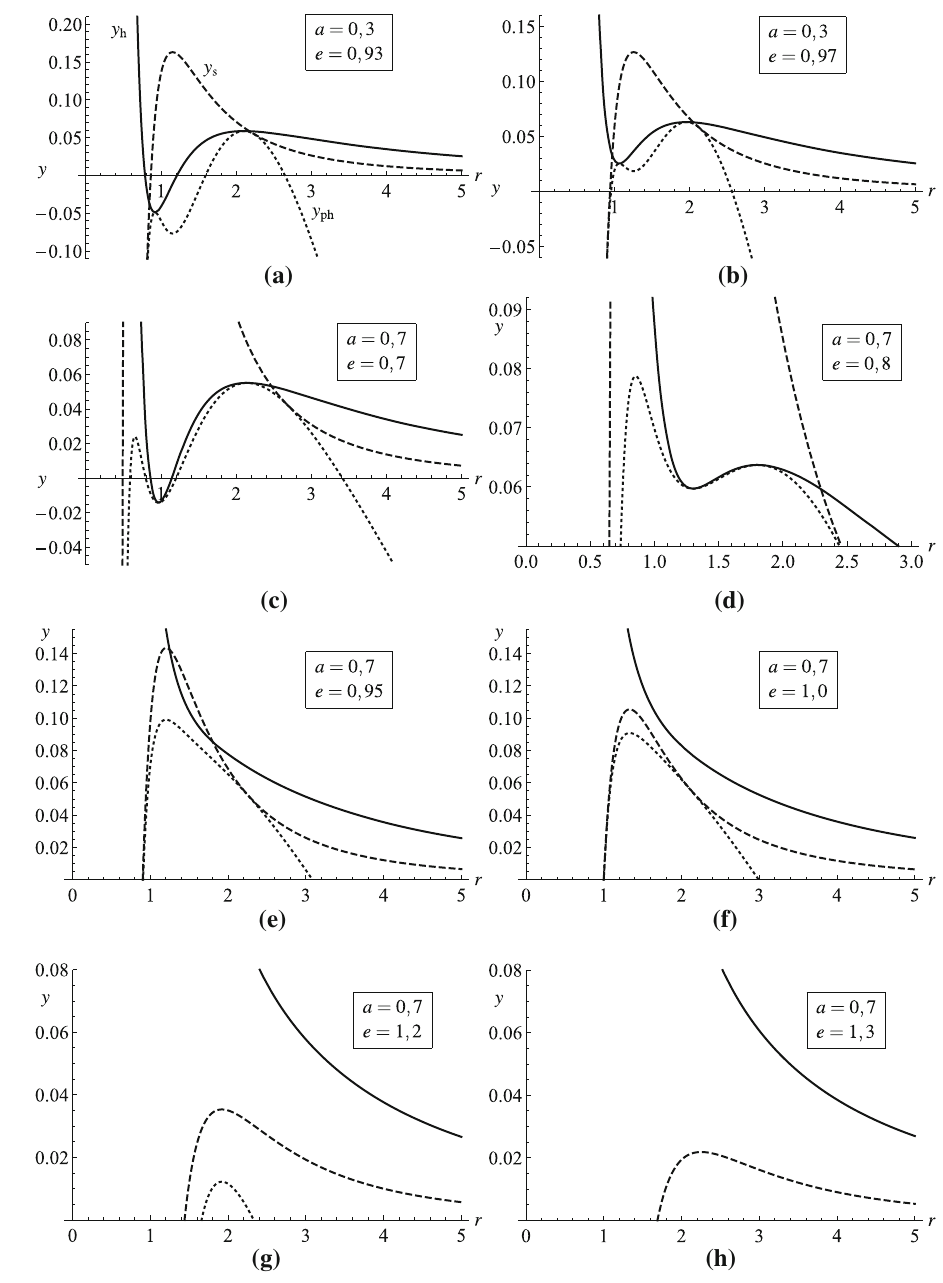
Fig. 4 Various profiles and positions of functions y h ( r ; a , e ) , y s ( r ; e ) and y ph ( r ; a , e ) determining for given values of spacetime parameters y , a , e locations of horizons (solid curve), static radii (dashed curve) and photon orbits (dotted